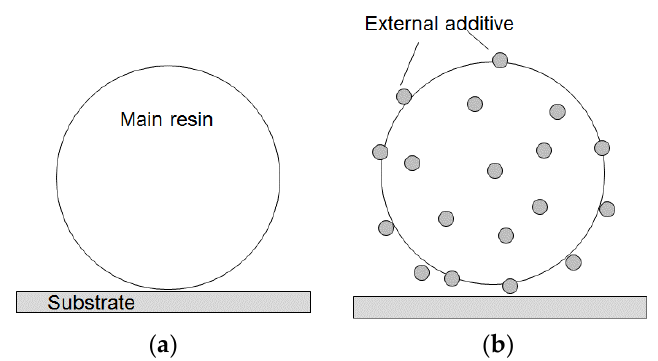
Figure 11. Effect of external additives on contact between a toner particle and a substrate: ( a ) without external additives; ( b ) with external additives.